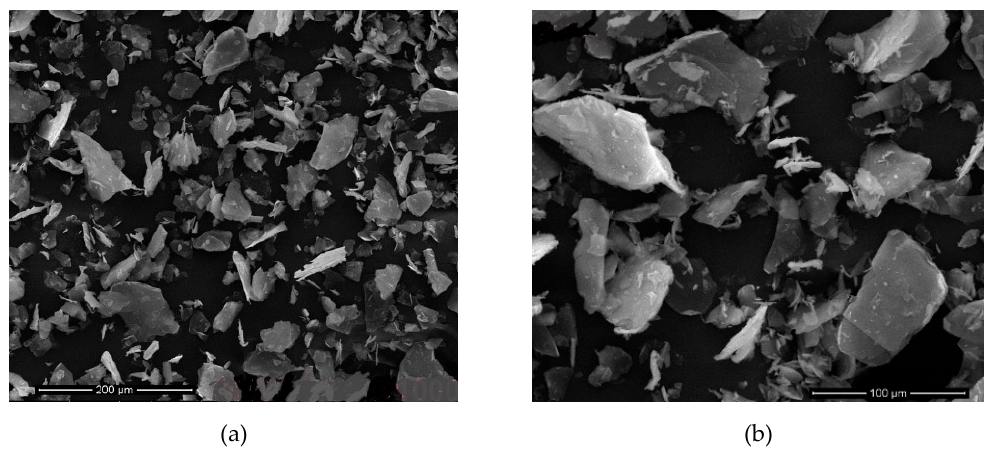
Figure 6. SEM images of the M x2c2 sample with a sonication time of 9 h (all images same as with higher